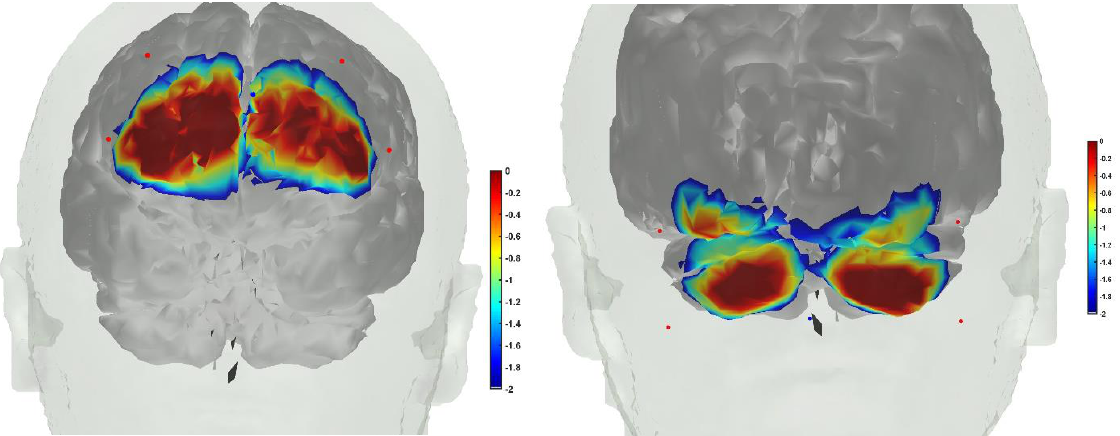
Figure 9. ( Left ) fNIRS sensitivity profile, where sources were positioned at AF7, AF3, AF8, AF4, and the detector was placed at the FPz. ( Right ) fNIRS sensitivity profile, where sources were positioned at PO7, PO9, PO8, and PO10, and the detector was placed at the